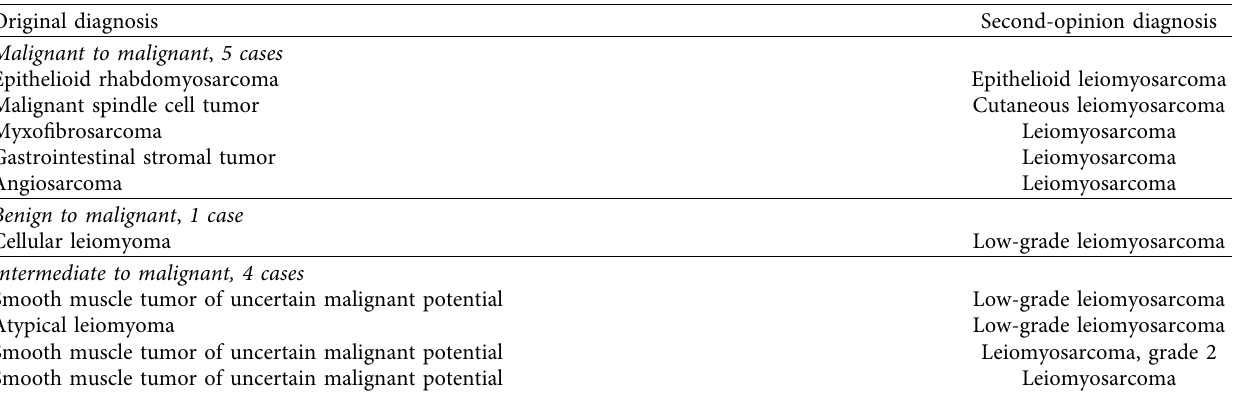
Table 4: Smooth muscle tumors with discrepancy in